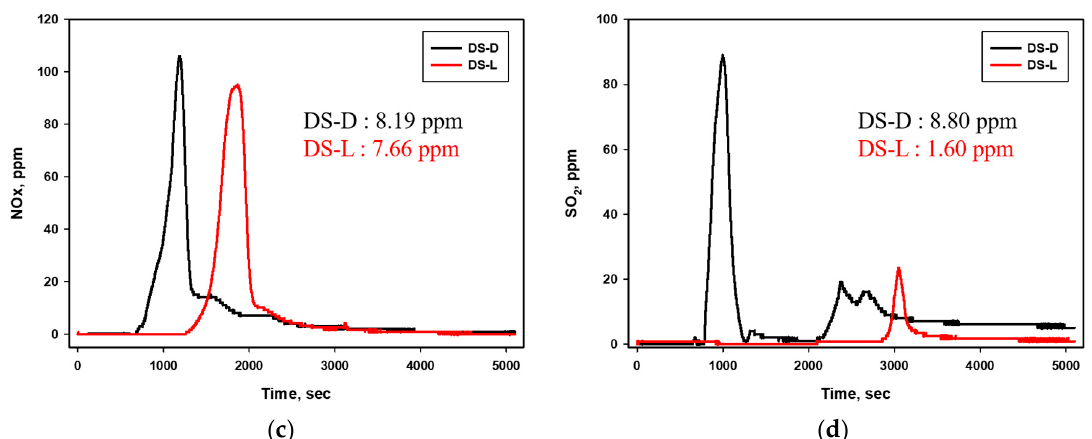
Figure 5. Flue gas emissions of DS-D and DS-L-10: ( a ) CO gas, ( b ) CxHy gas, ( c ) NOx, ( d ) SO 2 .